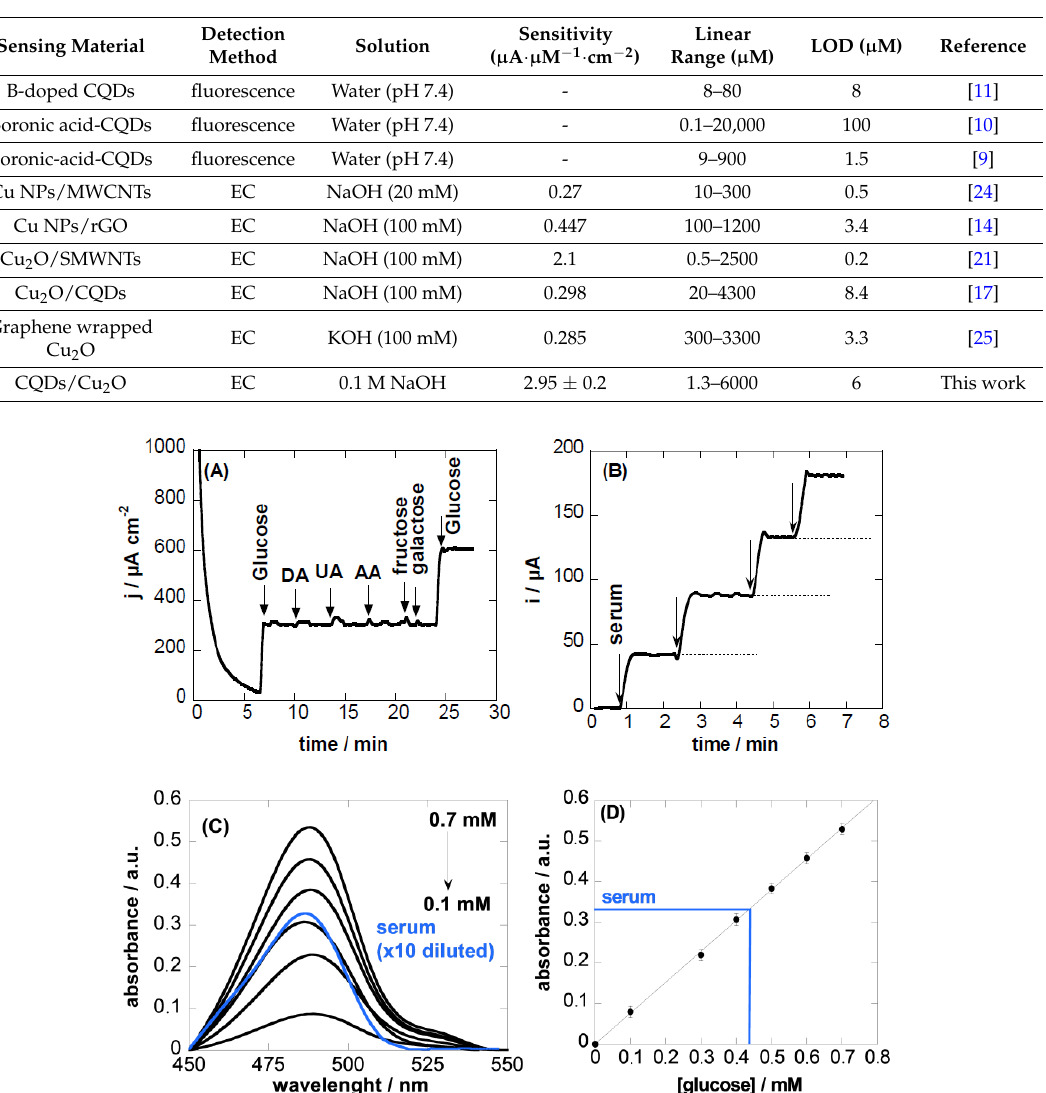
Table 1. Comparison of the analytical performance of other Cu-based non-enzymatic glucose sensors, as well as CQDs sensors. EC: electrochemical; LOD: limit of detection; rGO: reduced graphene oxide; MWCNTs: multi-walled carbon nanotubes.